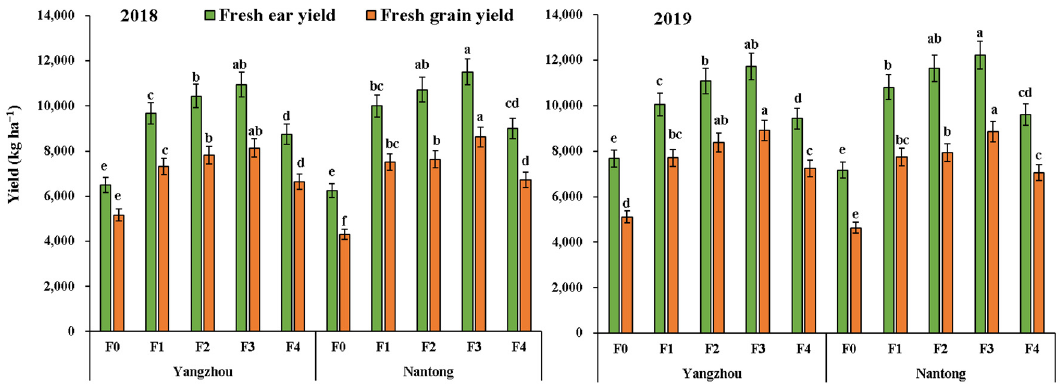
Figure 5. Effects of optimized fertilization practices on ear and grain yield of fresh waxy maize. Bars represent means ± standard deviation ( n = 3). Different letters above the bars represent significant differences at p < 0.05. F0: no fertilizer; F1, F2, and F3 represent new compound fertilizer applied 225 kg N ha − 1 at sowing, V3, and V6 stages, respectively; F4: applied 75 kg N ha − 1 traditional compound fertilizer at sowing stage and 150 kg N ha − 1 urea at V6 stage.